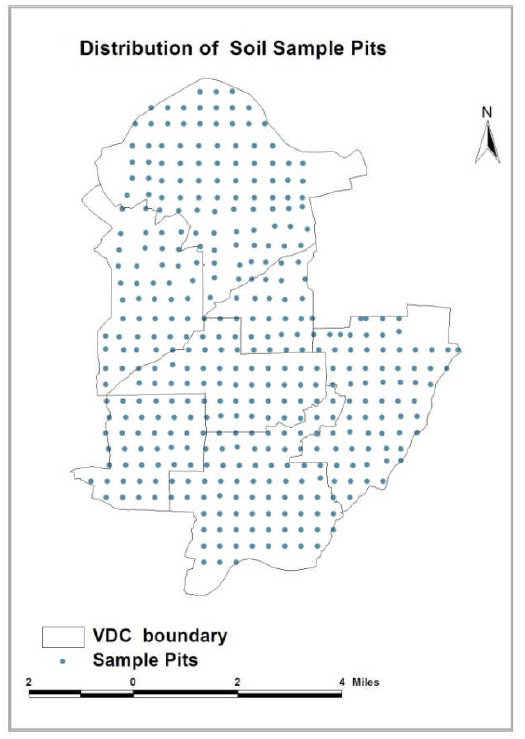
Fig 2: Distribution of soil